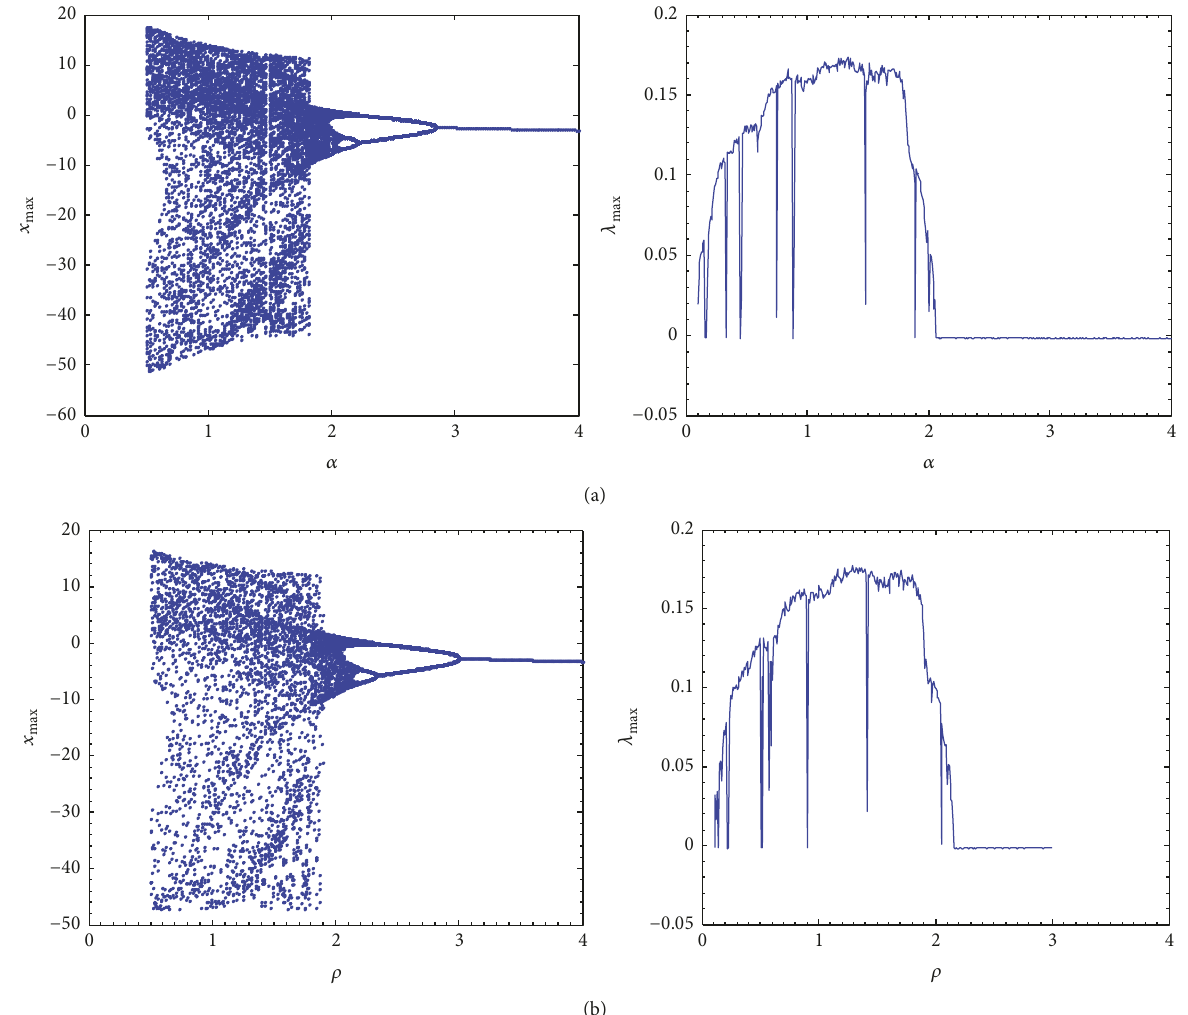
Figure 4: Bifurcation diagrams. (a): local maxima of the coordinate 𝑥(𝜏) versus 𝛼 of the jerk attractor for 𝜇 = 0.5 and the corresponding graphs of 1D largest numerical Lyapunov ( 𝜆 max ) exponent plotted in the range 0.5 ≤ 𝛼 ≤ 4 ; (b): local maxima of the coordinate 𝑥(𝜏) versus 𝜌 of the jerk attractor for 𝜇 = 0.5 and the corresponding graphs (b) of 1D largest numerical Lyapunov ( 𝜆 0.5 ≤ 𝜌 ≤ 3.5 .